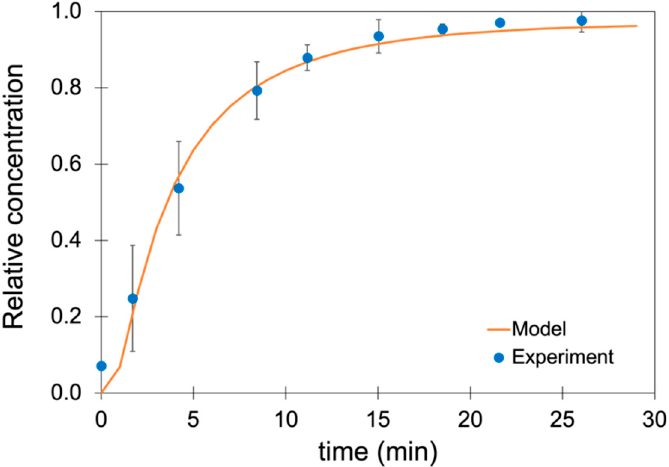
Figure 4. Non-reactive transport of NO 3 − through the geofilter and curve fitting with STANMOD. For the present fit, the retardation factor was adjusted to 1, as nitrate is considered non-reactive and no degradation was assumed. Thereafter, by the inverse method with STANMOD, v and D were determined as 0.38 and 0.43, respectively. Although larger errors are found at short term, the experimental data in the three replicates converge with the increasing time. The regression coefficient for the curve fitting is 0.99.